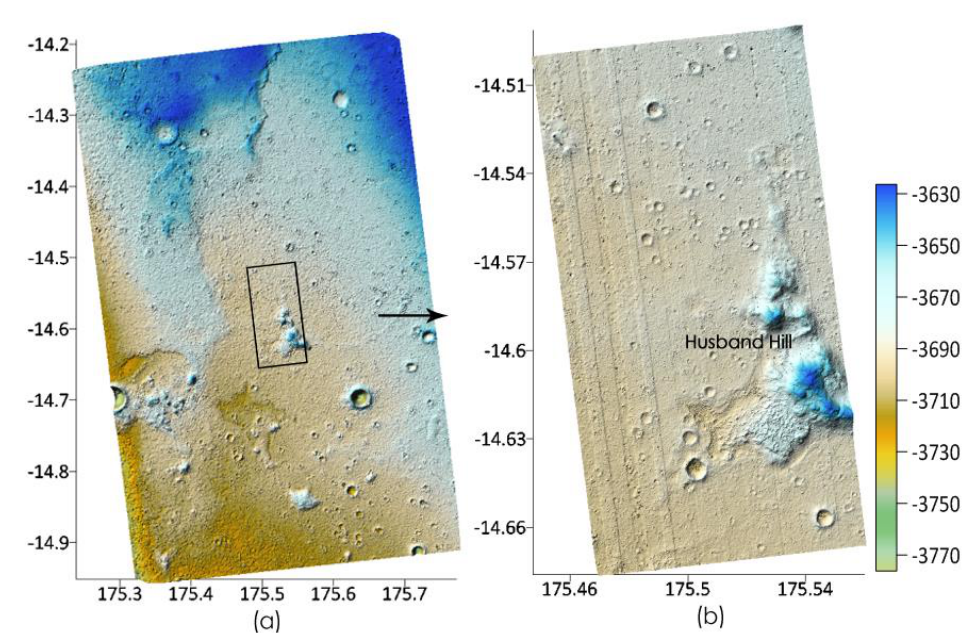
Figure 1. DEMs of the landing site of the Mars Exploration Rover Spirit. (a) DEM generated from CTX stereo pair, and (b) DEM generated from HiRISE stereo pair (it should be noted that the strip inconsistencies in the HiRISE DEM are due to the un-calibrated CCD alignments, which is not emphasized in this